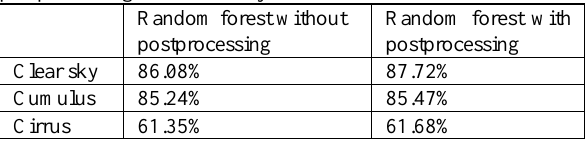
Table 2. The classification accuracy before and after postprocessing